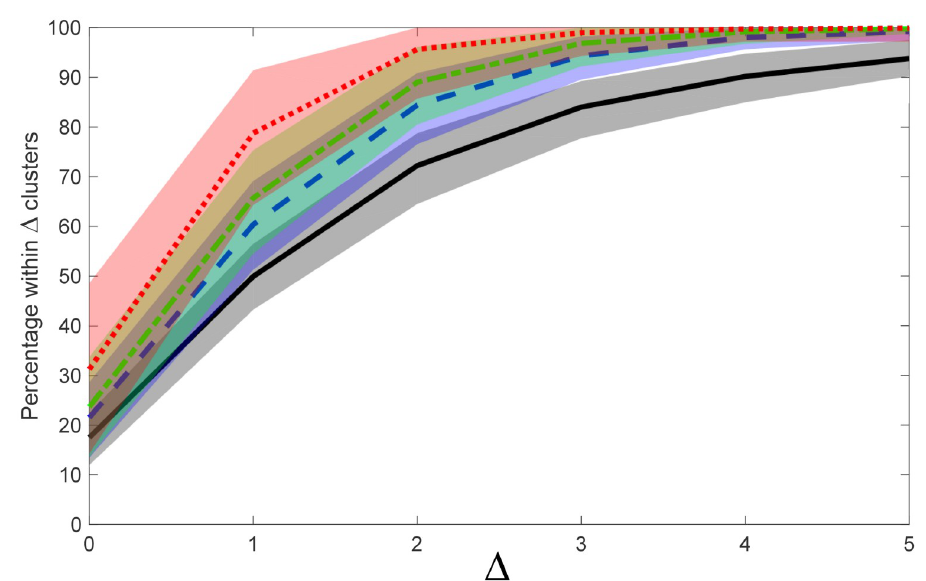
Fig 11. Effect of cluster number on model performance (Wikipedia data). Colour shaded regions represent 95% confidence interval with respect to mean percentage of model estimates lying within clusters of the true cluster number (corresponding coloured line), for text data only. Legend: dotted RED–estimates for samples containing up to 5 clusters; short-long segmented GREEN–estimates for up to 10 clusters; segmented BLUE–estimates for up to 15 clusters; solid BLACK–estimates for up to 20 clusters. Distance metric: L1 norm; histogram partitions: R = 40; embedding dimension: d E =